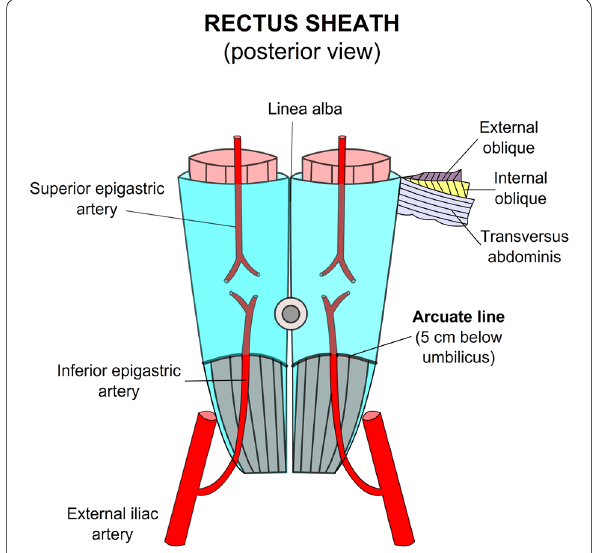
Fig. 3 Anatomy of the rectus sheath above and below the arcuate line observed from a posterior view. As noted, below the arcuate line, the posterior sheath is absent and thus the rectus muscle is in direct contact with the transversalis fascia